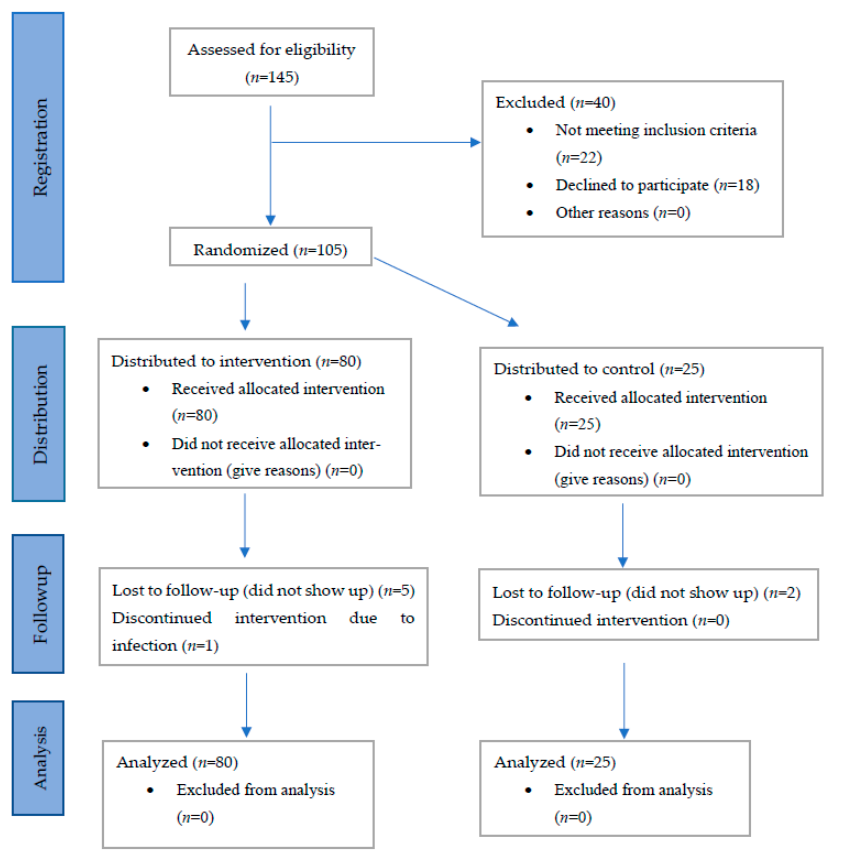
Figure 2. CONSORT flow chart.